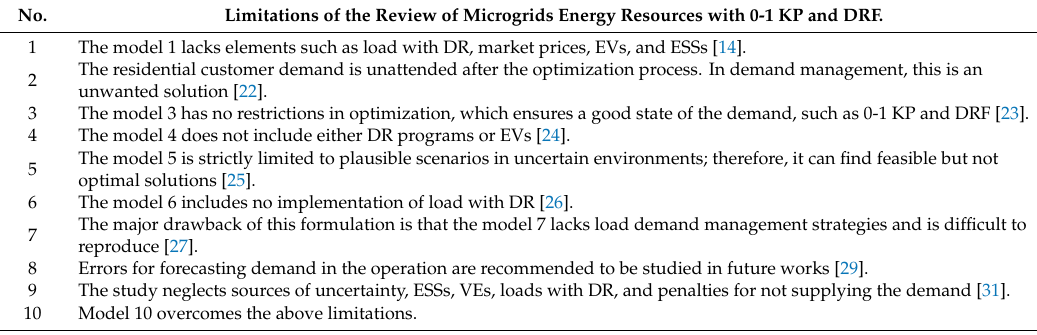
Table 2. Limitations of the review of microgrids with 0-1 KP and